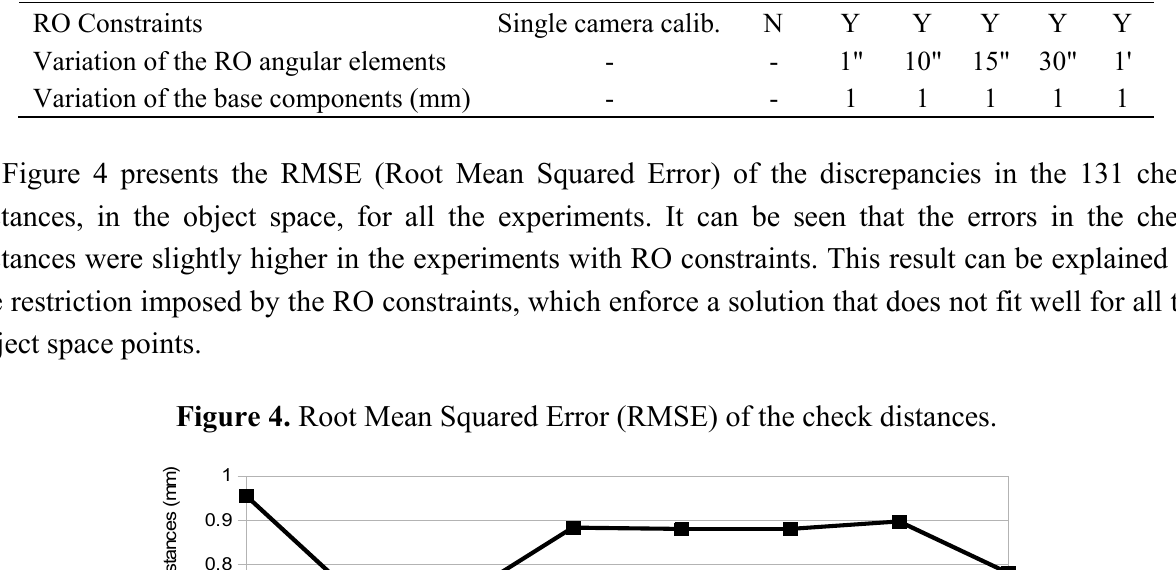
Figure 5. Estimated standard deviations of f , x